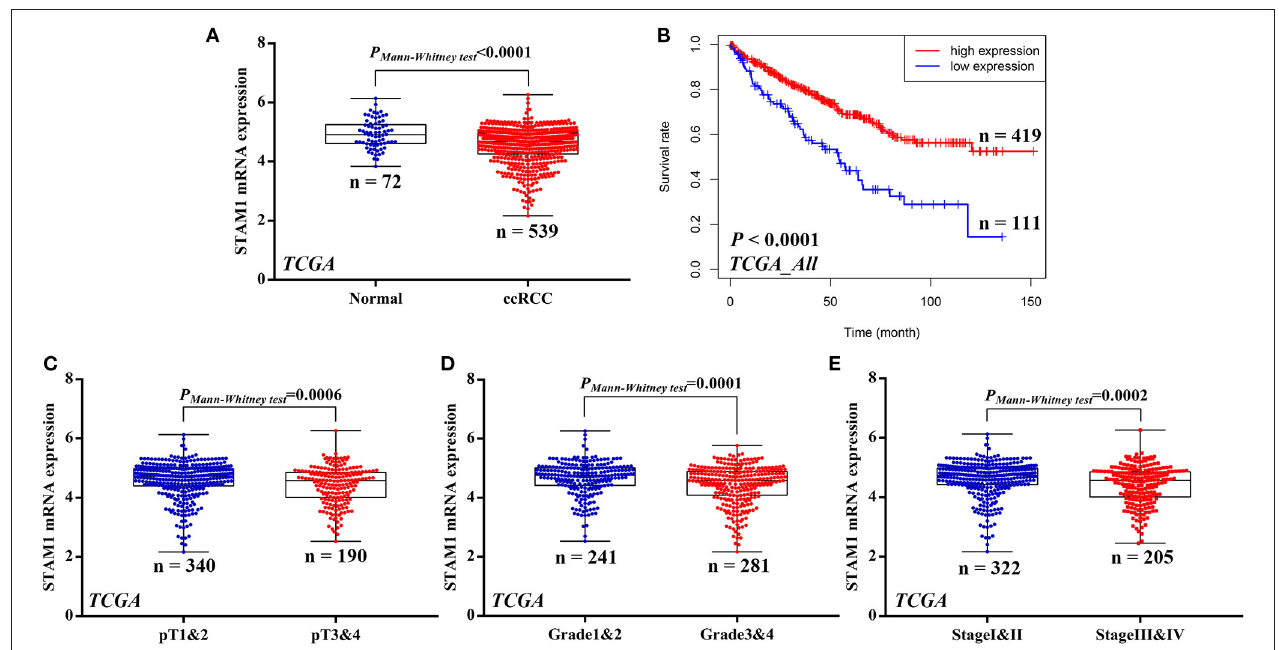
FIGURE 1 | mRNA expression of STAM1 and its association with survival in clear cell renal cell carcinoma (ccRCC) based on The Cancer Genome Atlas data mining. (A) Comparison of STAM1 mRNA level between ccRCC tissues and cancer-adjacent normal renal tissues. (B) Kaplan–Meier analysis of overall survival in patients with low and high STAM1 level. Comparisons of STAM1 mRNA levels in ccRCC patients with low and high pT stages (C) , tumor grades (D) , and American Joint Committee on Cancer stages (E) .